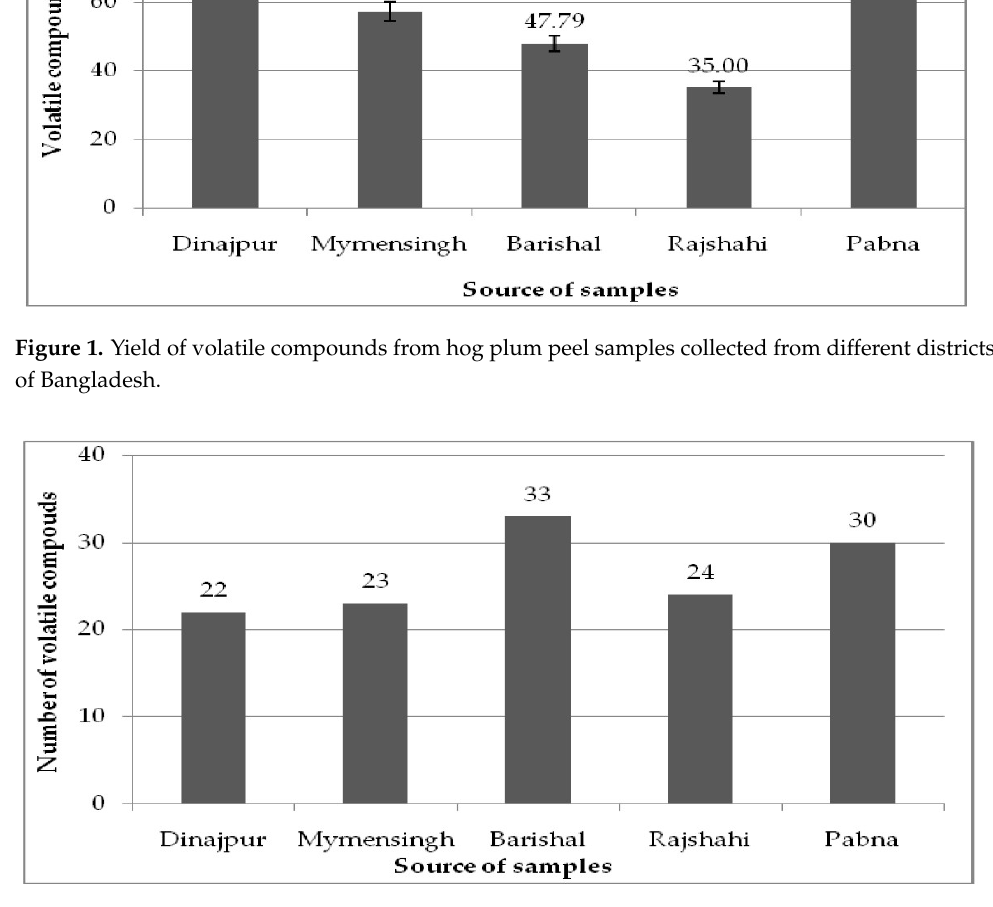
Figure 2. Number of volatile compounds identified from hog plum peel samples collected from different districts of Bangladesh.